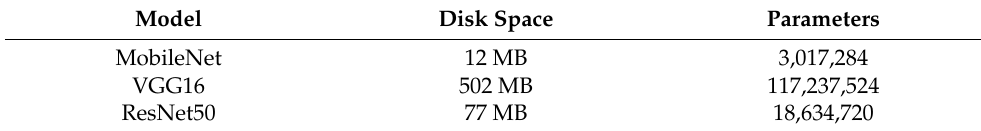
Table 6. Comparison of disk space and parameters between models. Table 7. Comparison of CNN image classification models.